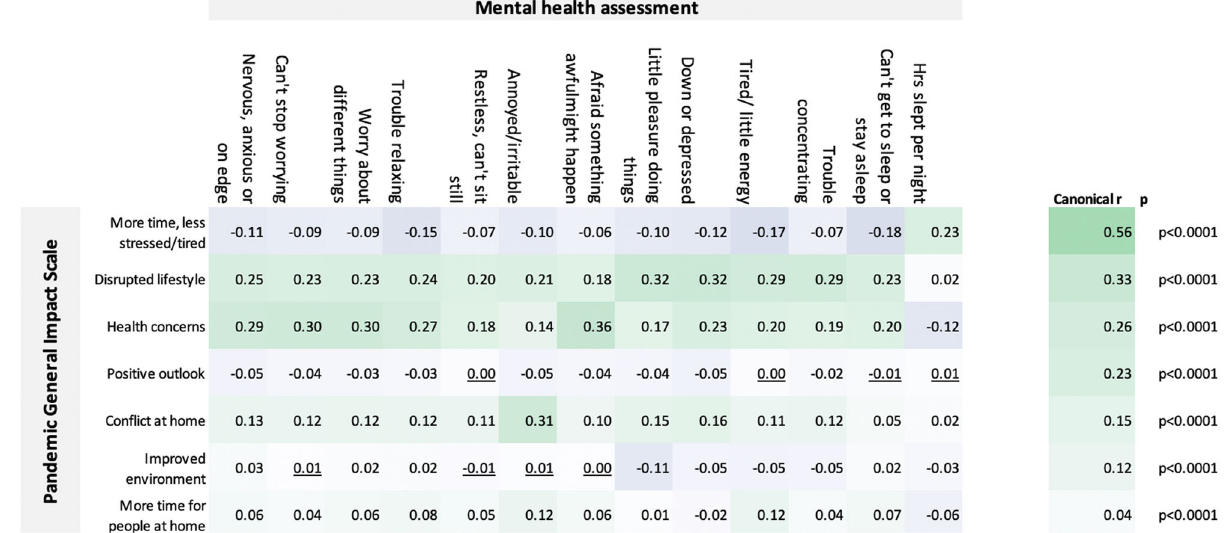
Fig. 5 Inter-relationships between the PD-GIS subscales and mental health assessment. Top left. Pearson ’ s bivariate correlation r values. Only a few correlations were statistically non-signi fi cant at p < 0.05 two tailed and FWE corrected for multiple comparisons (underlined). Signi fi cant correlations were evident between measures of self-perceived COVID-19 pandemic impact, as captured in the PD-GIS subscales, and the mood self-assessment items. Top right. Canonical correlation analysis con fi rmed this relationship in a multivariate manner, with 7 statistically signi fi cant correlation modes as evaluated using Bartlett ’ s approximate chi-squared statistic for H ( k )0 with Lawley ’ s modi fi cation, the largest with canonical r = 0.56 and the last mode signi fi cant at p = 6.5e − 26. These results show that the effects of the pandemic on daily life have a signi fi cant component in explaining individual differences in standard mental health assessment measures. Source data are provided as a Source data fi